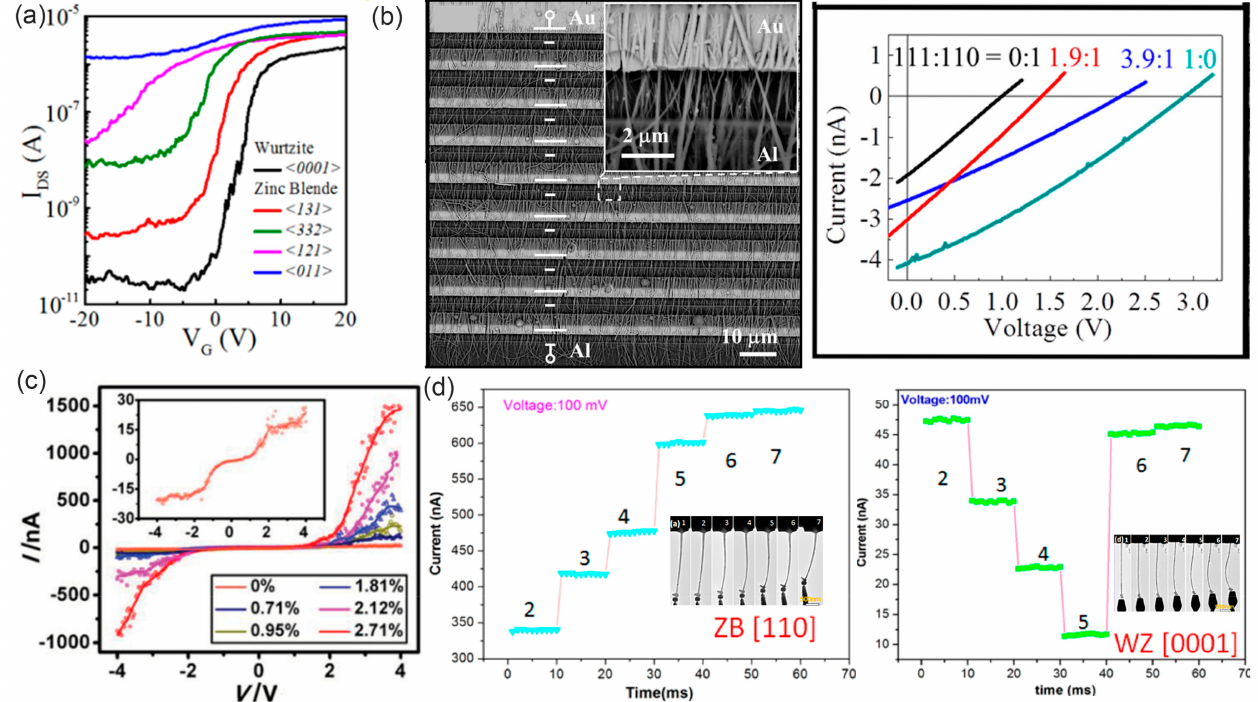
Figure 10. ( a ) I DS -V G characteristics of the back-gated NW FETs for five different oriented InAs NWs in logarithmic coordinates. Reproduced with permission [104]. Copyright 2016, American Chemical Society. ( b ) Output performance of the cells fabricated with different mixing ratios of <111>- and <110>-oriented NWs. Reproduced with permission [107]. Copyright 2016, American Chemical Society. ( c ) Electromechanical measurement of [0001]-grown WZ InAs NWs and the I-V curves of the NW measured at various tensile strains. Reproduced with permission [116]. Copyright 2015, WILEY-VCH Verlag GmbH & Co. KGaA, Weinheim. ( d ) Variation of the current with increasing deformation of the ZB <110> InAs NW and WZ <0001> InAs NW under a bias of 0.1 V. Reproduced with permission [117]. Copyright 2016, American Chemical